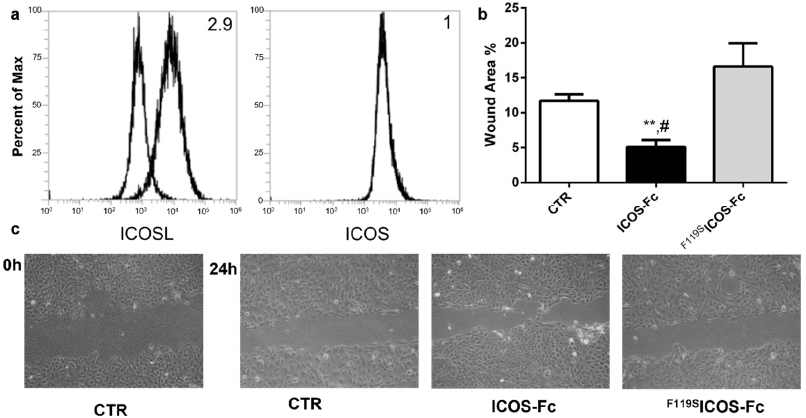
Figure 1. Effect of ICOS-Fc stimulation on the motility of HaCat cells by scratch assay. HaCat cells were cultured to confluence on 6-well plates. A scratch was made through the cell layer using a pipette tip and cells were then cultured in the presence or absence of 2 µg/mL ICOS-Fc or F119S ICOS-Fc for 24 h. ( a ) ICOS and ICOSL expression in HaCat cells. ( b ) Wound area % after 24 h of treatment as above, calculated as: 1 − (scratch width of the treated group/scratch width of the control group) × 100; results are the means from three independent experiments; ** p < 0.01 vs. CTR; # p < 0.05 vs. F119S ICOS-Fc, calculated by paired t -test. ( c ) Representative microphotographs of the wounded area taken immediately after the scratch was made 0 h and 24 h later to monitor cell migration into the wounded area (original magnification 10×).